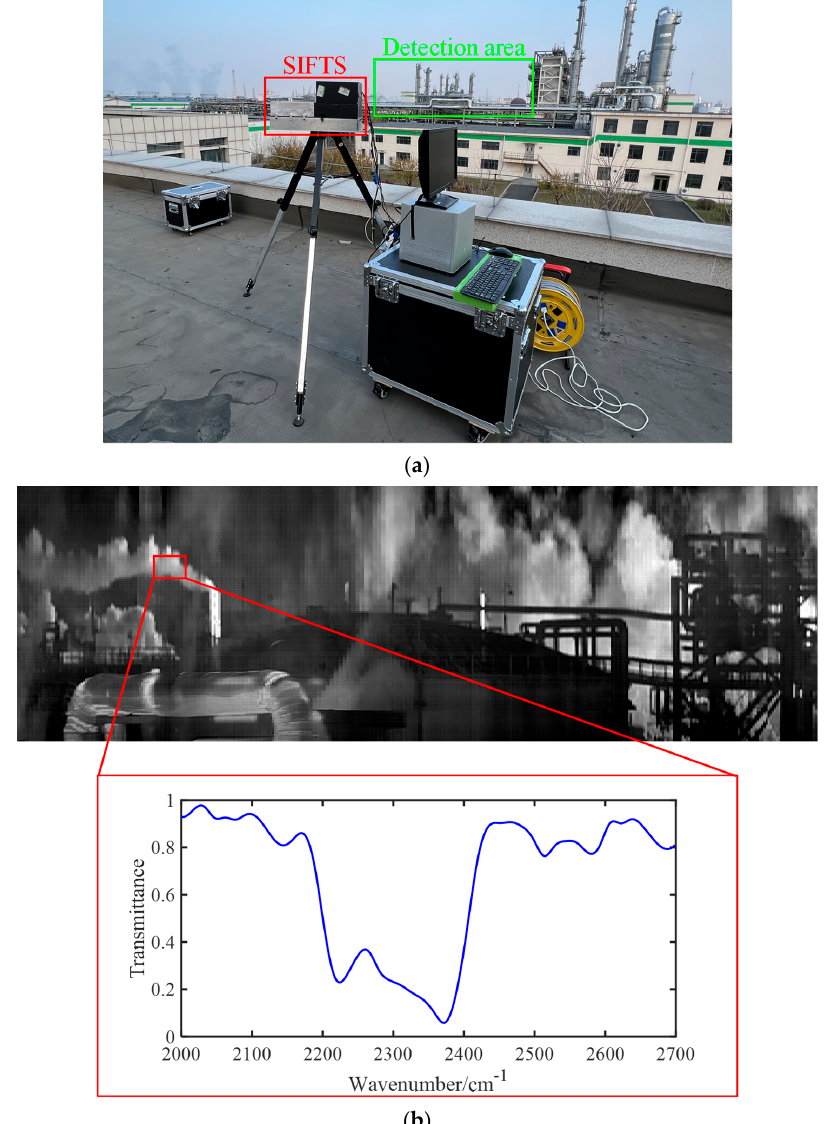
Figure 18. ( a ) Field experiment site. ( b ) The infrared image of the detection region and the transmittance spectrum of the target region.